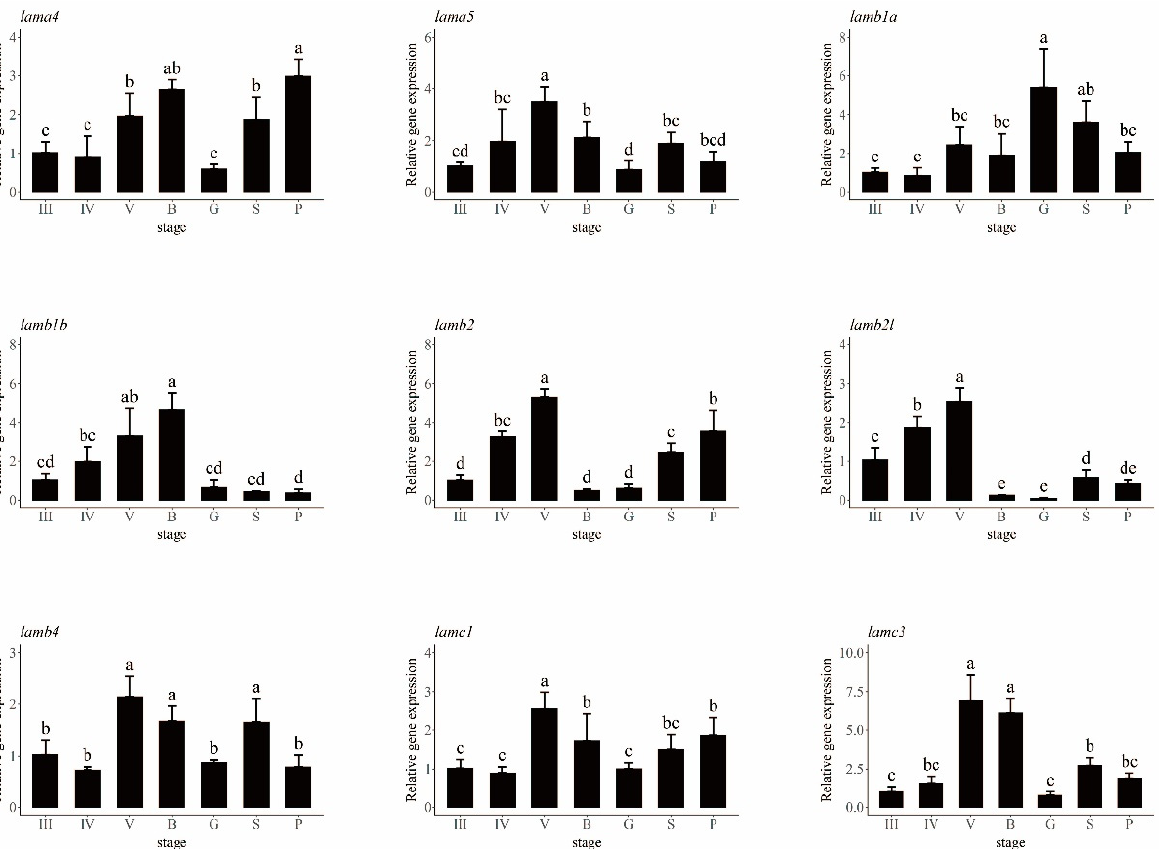
Figure 6. Expression analysis of laminin genes at seven different ovarian development stages. The relative expression levels of laminin genes are shown in different colors. III: ovary at stage III; IV: ovary at stage IV; V: ovary at stage V; B: blastula stage; G: gastrula stage; S: somites stage; P: pre-hatching stage. Different letters are signs of significant differences.